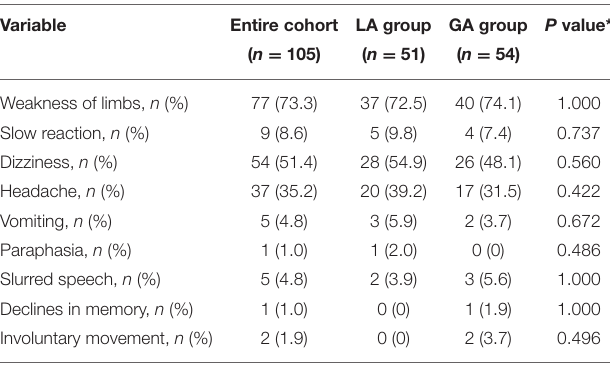
TABLE 2 | Preoperative